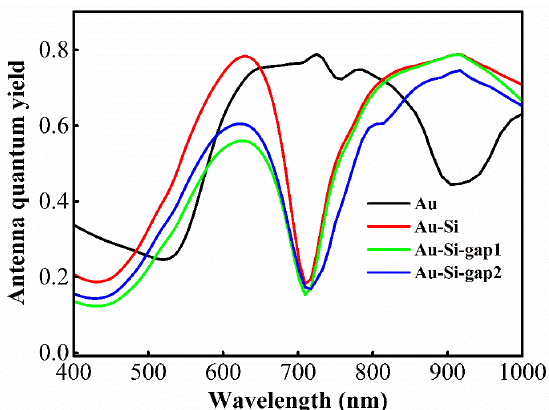
Figure 5. Antenna quantum yield as a function of wavelength from 400 nm to 1000 nm for four nano-aperture antennas shown in Figure 4. All of the calculations are performed for a dipole at the position (0, 0, and 10 nm). The Au-Si-gap1 and Au-Si-gap2 refer to the structures in Figure 4c,d, respectively.